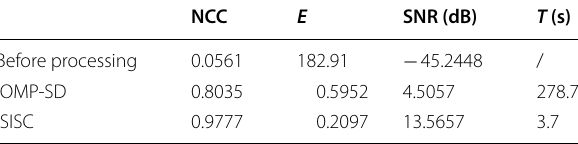
Table 1 Quantitative evaluation of pseudo‑random square‑wave noise processing